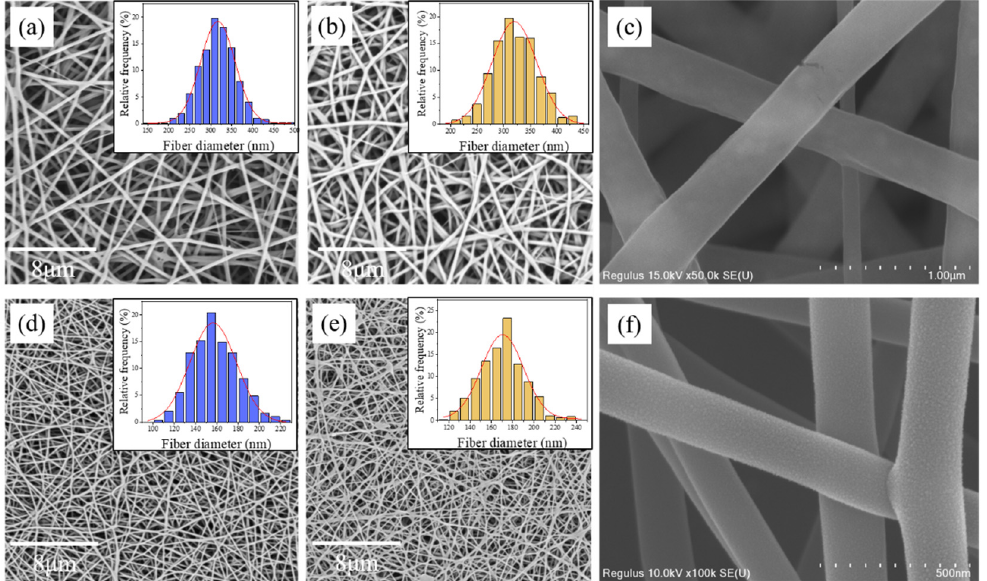
Figure 4. SEM images of PVA/EH/CBS nanofibers ( a ) before immersion in water, ( b ) immersion in water, ( c ) enlarged view of fibers and PVA/BI nanofibers ( d ) before immersion in water, ( e ) immersion in water, ( f ) enlarged view of fibers.